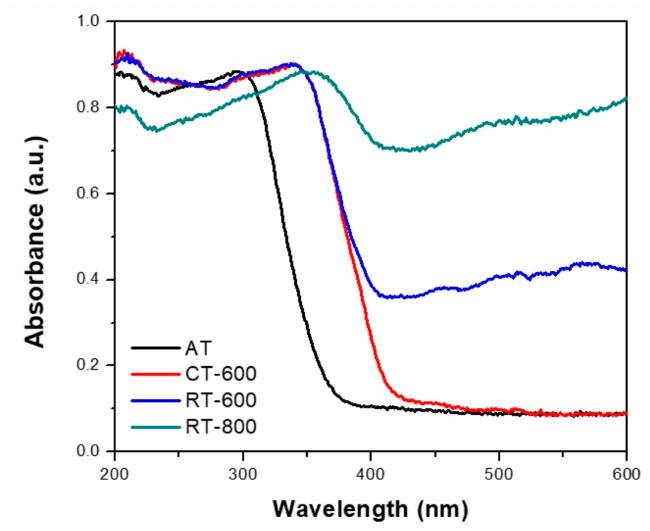
Figure 5. UV-Vis di ff use reflectance spectroscopy (UV-Vis DRS) spectra of amorphous TiO 2 (AT), CT-600, RT-600, and RT-800.